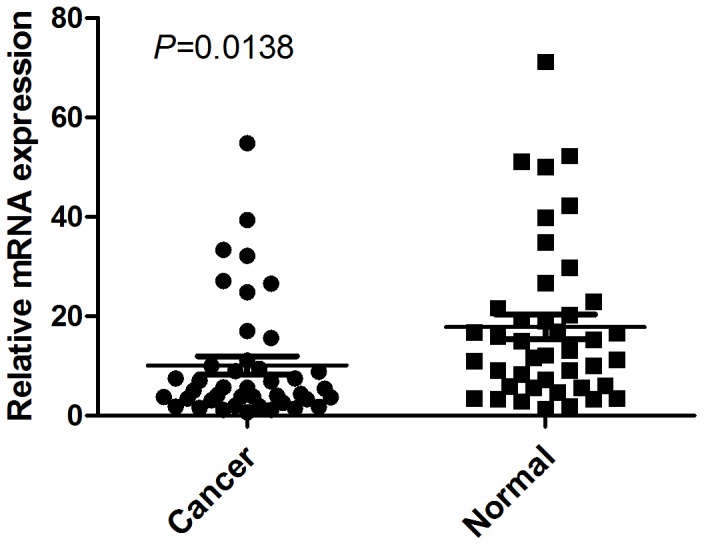
The mRNA expression of PTPRD in human primary gastric adenocarcinoma surgical specimens was evaluated by qRT-PCR.The relative mRNA expression of PTPRD was significantly decreased in GC tissues compared with the matched adjacent noncancerous tissues (n = 42, P = 0.0138). Horizontal lines represent the mean.